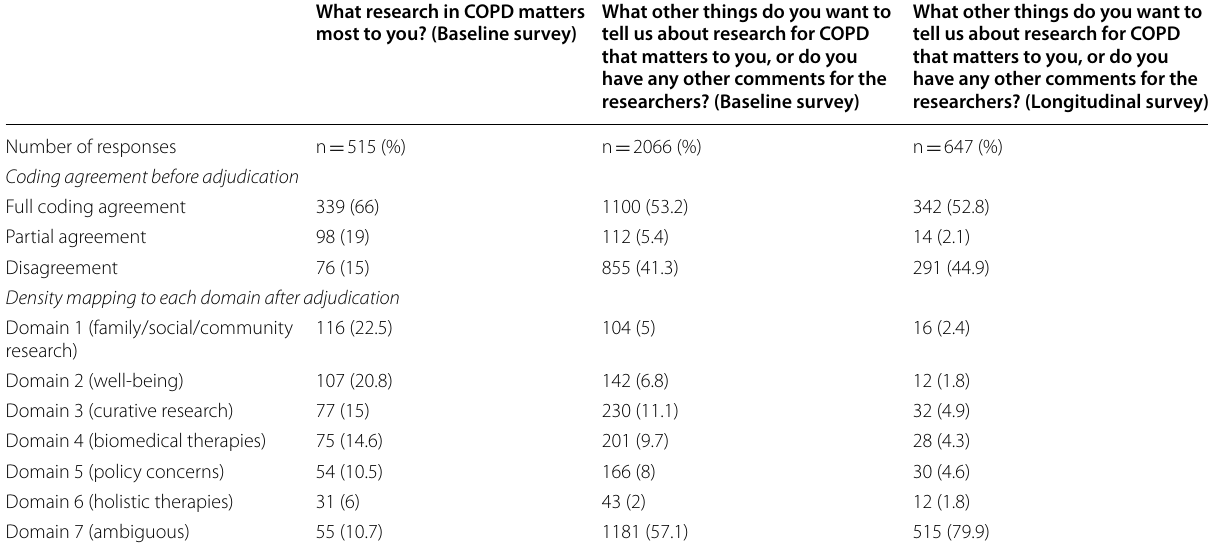
Table 1 Coding agreement and density